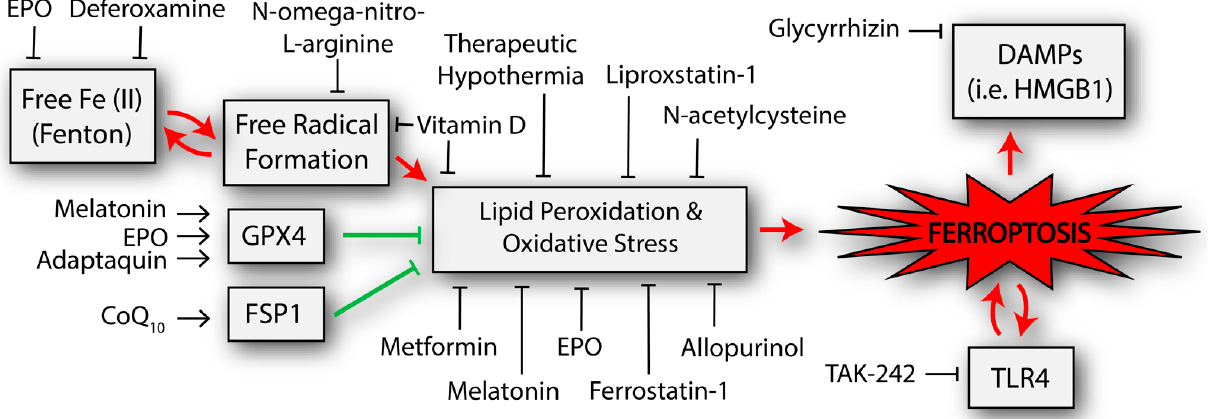
Figure 2. Potential neuroprotective interventions that have been shown to affect the ferroptosis- related pathways in studies of neonatal hypoxic-ischemic brain injury. Other interventions that have been trialed in adult populations but not yet neonates are described in the text but not included in the figure. The double arrows represent byproducts that can further potentiate the initial process (e.g., TLR4 is increased from the process of ferroptosis but TLR4 appears to also activate ferroptosis). CoQ 10 , coenzyme Q 10 ; DAMPs, damage associated molecular patterns; EPO, erythropoietin; FSP1, ferroptosis suppressor protein 1; GPX4, glutathione peroxidase 4; HMGB1, high mobility group box 1; TLR4, toll-like receptor 4.